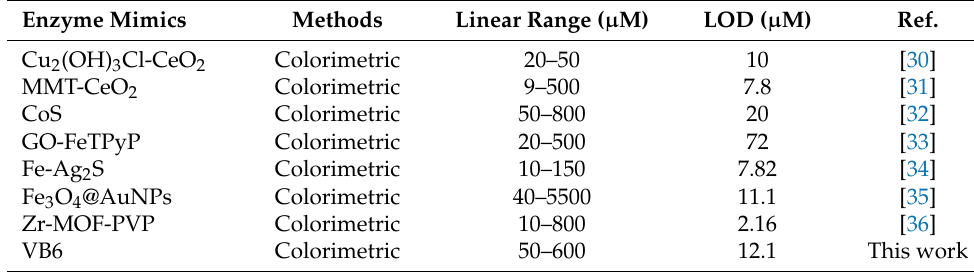
Table 1. Comparisons of colorimetric detection of H 2 O 2 by various peroxidase mimics. Enzyme Mimics